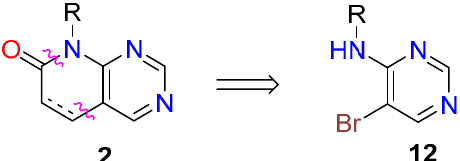
Figure 8. Synthetic approach for pyrido[2,3- d ]pyrimidin-7(8 H )-ones ( 2 ) from a preformed 4-amino-5-bromopyrimidine ( 12 ).